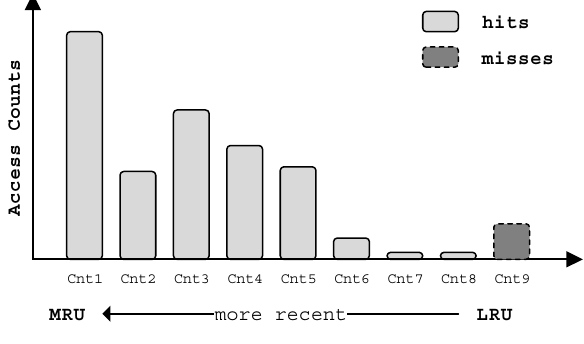
Figure 2. LRU stack counters for monitoring.